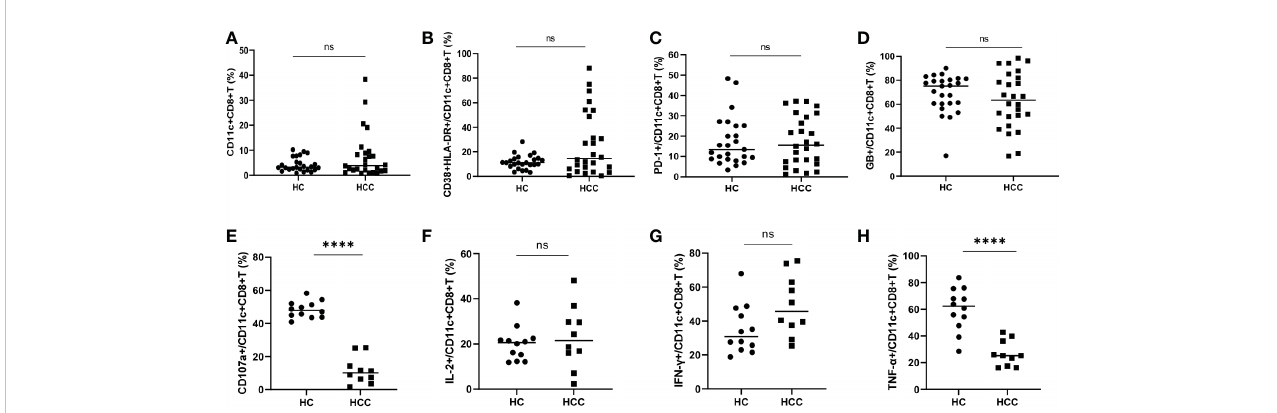
FIGURE 2 Frequency of CD11c + CD8 + T cells in HCC and HC groups. (A) The frequency of CD11c + CD8 + T cells in HCC (n = 26) and HC (n = 25) groups. (B – D) The levels of CD38 & HLA-DR, PD-1, and GB expression of CD11c + CD8 + T cells in HCC (n = 26) and HC (n = 25) groups. (E – H) After PMA stimulation, the level of CD107a expression and IL-2, IFN- g , and TNF- a production of CD11c + CD8 + T cells were detected in HCC (n = 10) and HC (n = 12) groups. The Mann-Whitney U test was used to compare the median values between the two groups. **** P < 0.001; ns, not signi fi cant.